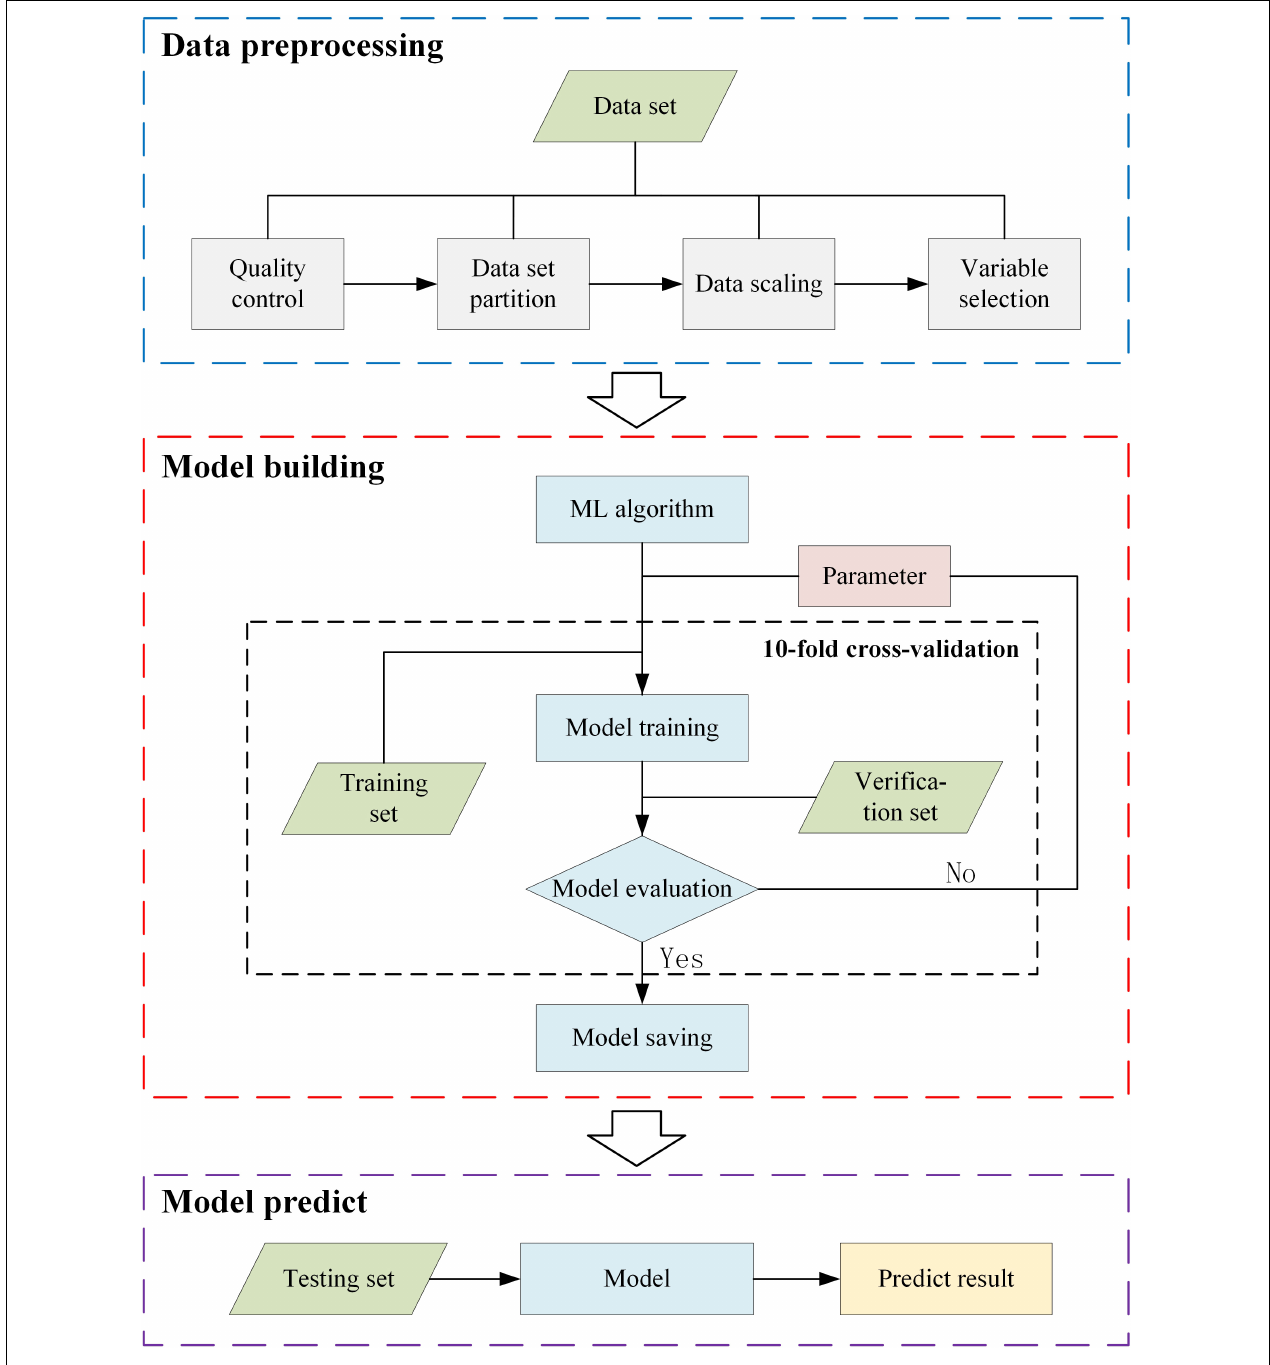
FIGURE 3 | Flow chart of the machine learning models used to estimate solar radiation.